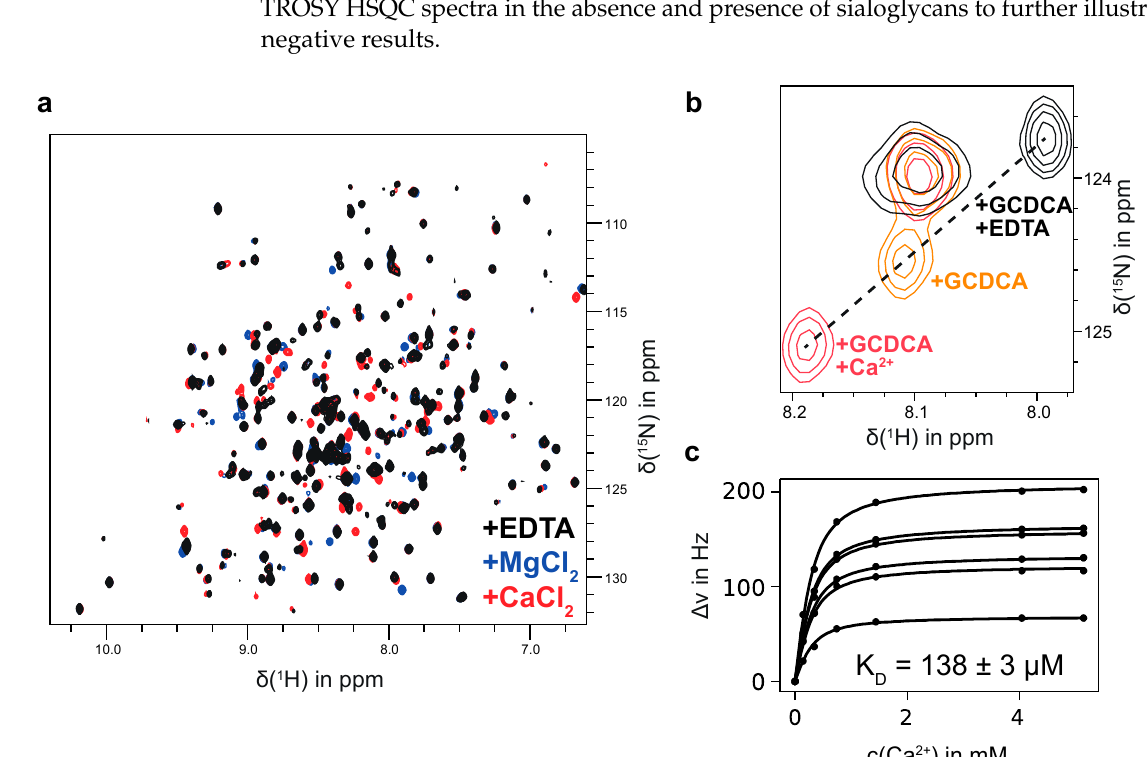
Figure 3. ( a ) 1 H, 15 N TROSY HSQC spectra of 150 µ M [ U - 2 H, 15 N]-labeled CW1 P-domain saturated with GCDCA (black contours) and in the presence of 5 mM MgCl 2 (blue contours) or CaCl 2 (red contours). No assignment is available yet, but the same set of signals is affected by both Mg 2+ and Ca 2+ indicating a shared binding pocket. ( b ) Effects of adding EDTA or Ca 2+ to the P-domain in the presence of saturating amounts of GCDCA. Black contours correspond to the respective spectrum in ( a ). Addition of EDTA (black) shifts the resonance signal in the opposite direction as addition of Ca 2+ (red) showing that GCDCA contains a significant amount of calcium ions. Therefore, all P-domain samples having GCDCA added also contain an undefined amount of Ca 2+ . ( c ) Euclidean CSPs can be calculated from a Ca 2+ titration series with the chemical shifts of an EDTA-treated sample taken as starting points. Due to the Ca 2+ contamination the total Ca 2+ concentration during the titration is not known precisely. Using the amount of added Ca 2+ ions, a global least-squares minimization of CSPs larger than two standard deviations were used to derive both, the initial Ca 2+ concentration and the dissociation constant K D . This approach yields a K D value of 138 µ M. With 300 µ M GCDCA, the initial Ca 2+ contamination was determined as 140 µ M. Spectra were acquired in 20 mM sodium acetate, 100 mM NaCl (pH 5.3). Ca 2+ was titrated to a sample containing 250 µ M P-domain.